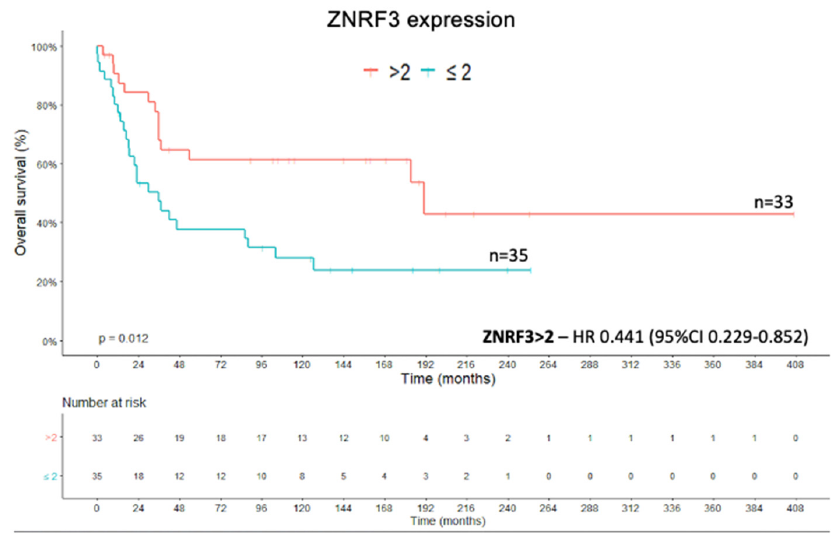
Figure 3. ZNRF3 protein expression—OS Kaplan–Meier curve. ZNRF3 is considered a suppressor of the Wnt/ β -catenin pathway. Due to this known function, we analyzed the status of β -catenin in the tumoral cells. Active Wnt/ β -catenin signaling was characterized by a cytoplasmic/nuclear staining for β -catenin [37]. The analysis demonstrated a positive correlation between ZNRF3 expression and β -catenin expression in the cell membrane (coefficient 0.202; p = 0.004; Spearman’s rank correlation coefficient). These data support the function of ZNRF3 as a tumor suppressor, keeping β -catenin attached in the cell membrane (Figure 4).